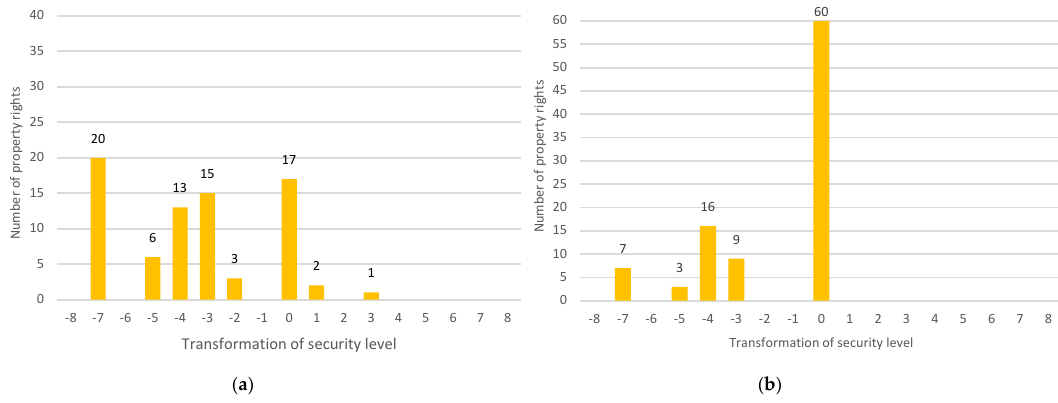
Figure 10. Transformation of the security level of property rights in KBP ( a ) cultivated and ( b ) residential lands.